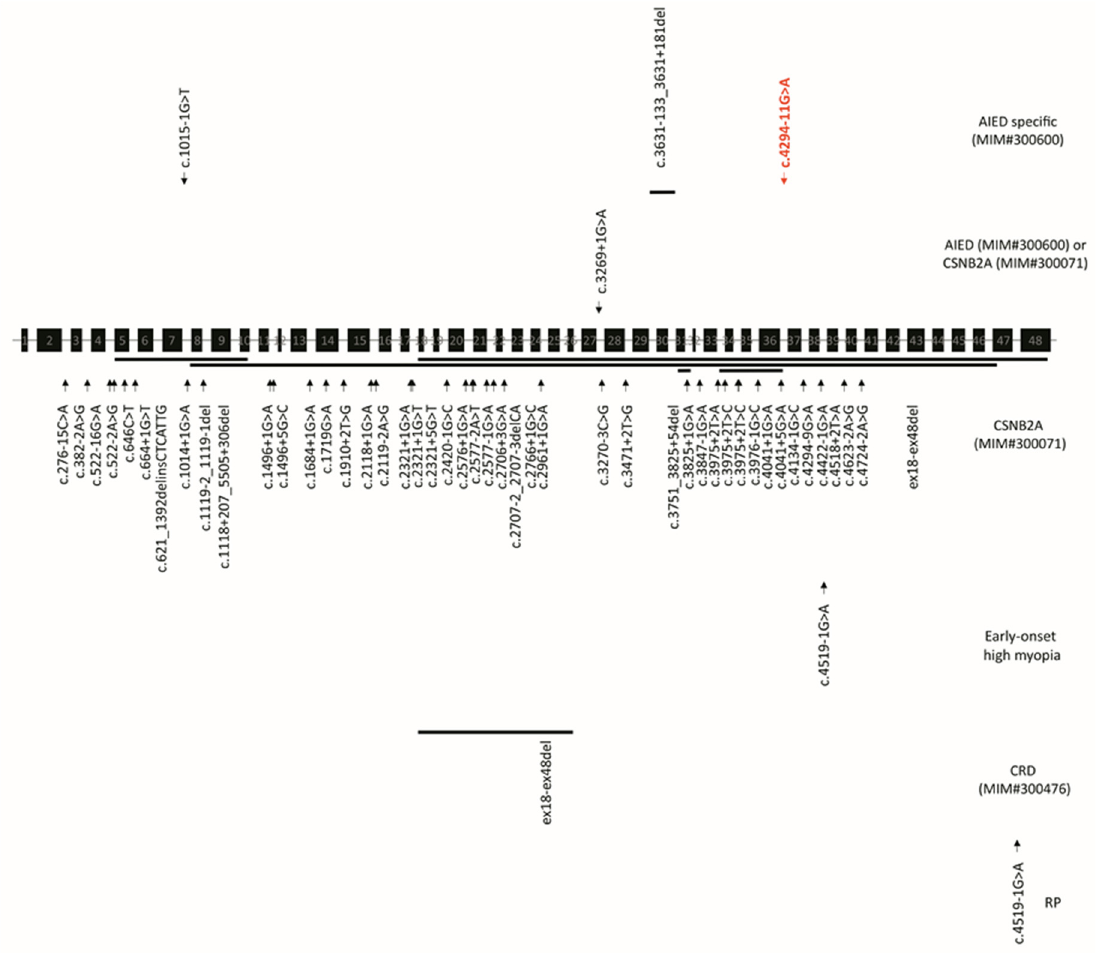
Figure 4. Disease-causing variants associated with CACNA1F -related disorders. Splice-site variants and large deletions/insertions are depicted in the 48 exons of CACNA1F (NM_005183.4). Red variant is reported in this study. Abbreviations: AIED—Åland island eye disease, CSNB2A—congenital stationary night blindness, CRD—cone-rod dystrophy, RP—retinitis pigmentosa.